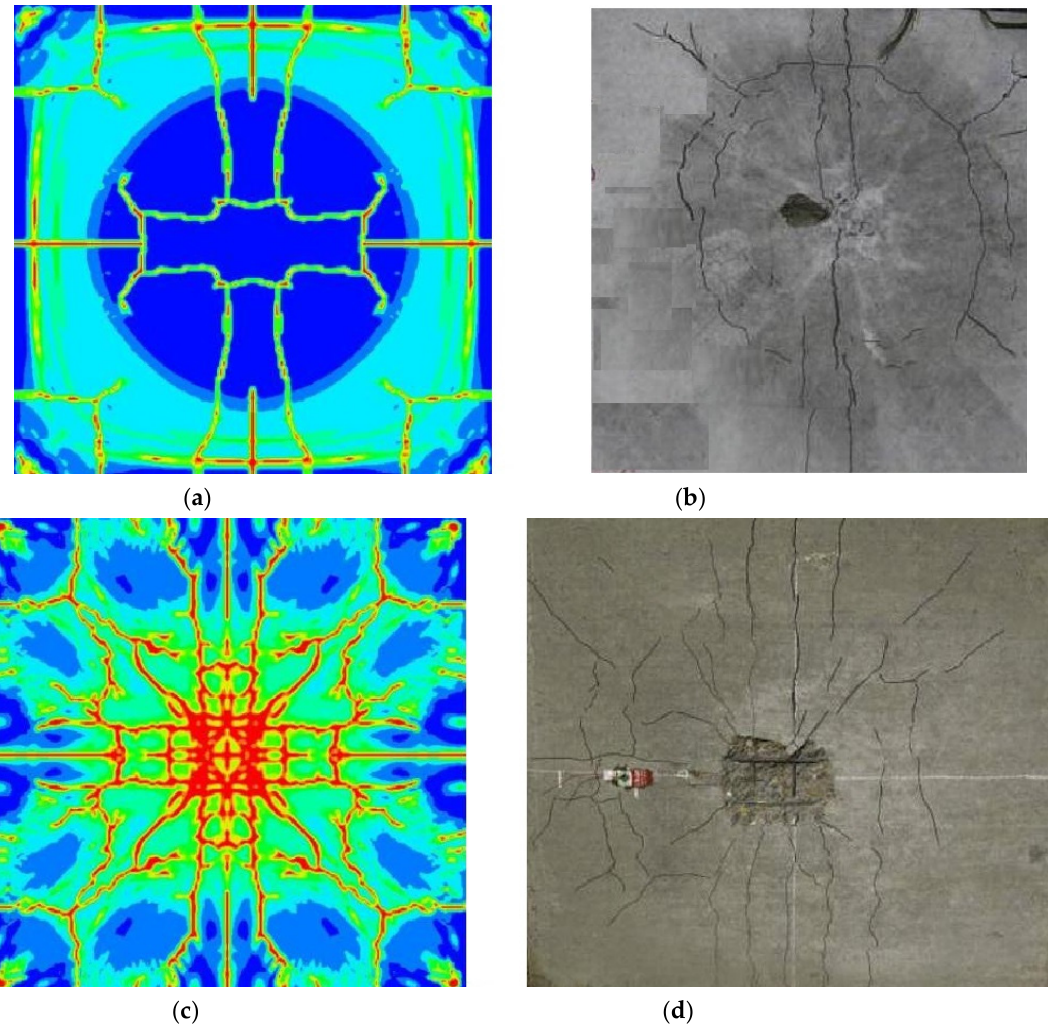
Figure 4. Failure of strengthened concrete slabs under a 0.31 kg TNT blast impact. ( a ) Numerical calculation results of blasting face; ( b ) test results of blasting face. ( c ) Numerical results of the back blasting face; ( d ) test results of the back blasting face.